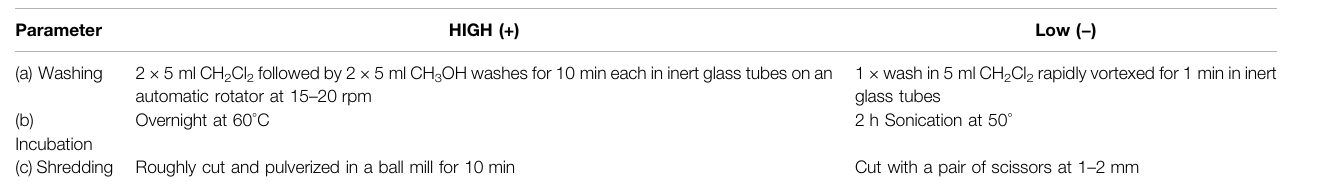
TABLE 2 | Values of the variables considered for the optimization of the pretreatment protocol.